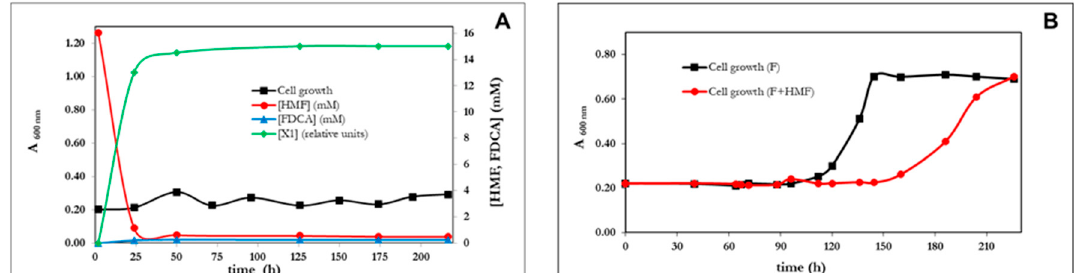
Figure 3. Biotransformation of HMF by P. pseudoalcaligenes CECT 5344 R1. ( A ) Cell growth (black line), concentration of HMF and FDCA (mM), and an unknown metabolite in cell cultures of P. pseudoalcaligenes . ( B ) Effect of HMF (5 mM) on the cell growth of P. pseudoalcaligenes at the expense of 10 mM furfural (F+HMF) in comparison with the cell growth with 10 mM furfural (F, black line). Similar results were obtained in three different experiments.